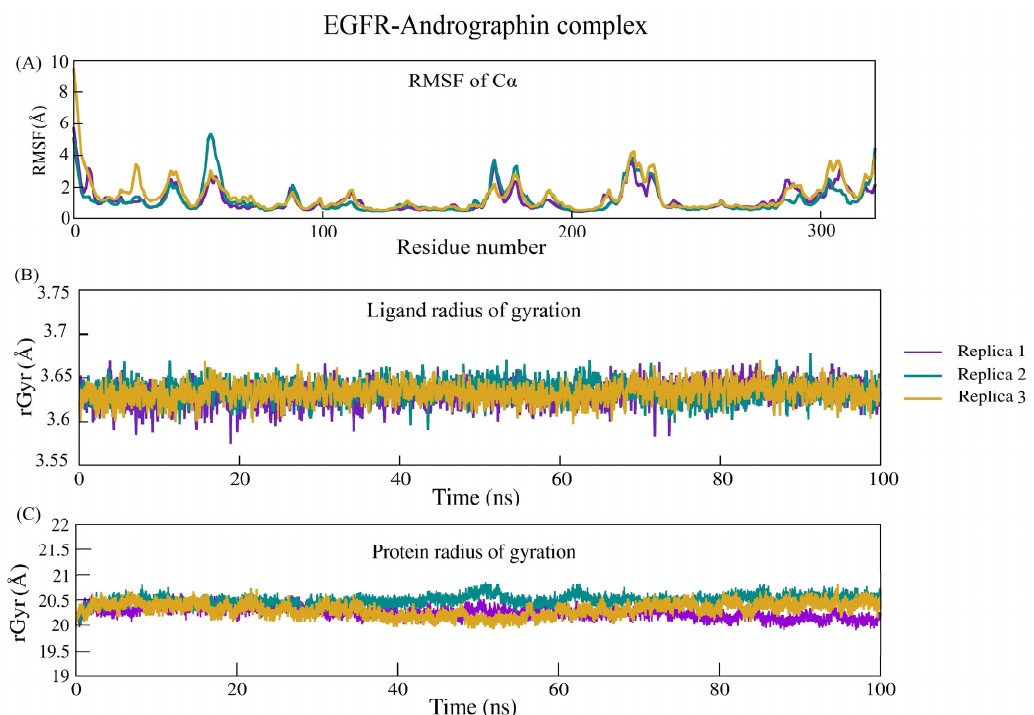
Figure 7. EGFR–Andrographin complex 100 ns MD production run. ( A ) Protein RMSF plot. ( B ) A gyration plot depicting the extendedness of a ligand. ( C ) A gyration plot of protein during a 100 ns production run.